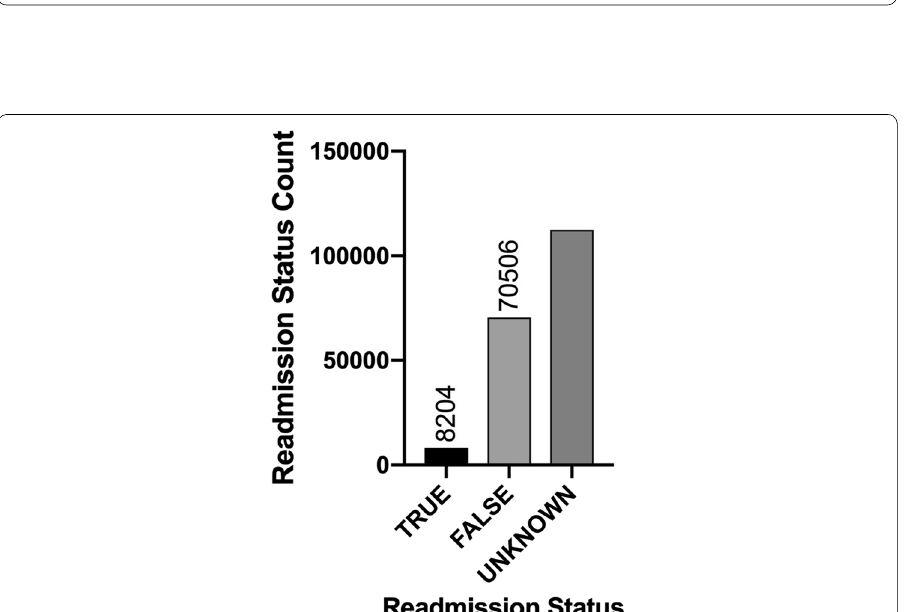
Fig. 3 Discharge summary count by readmission